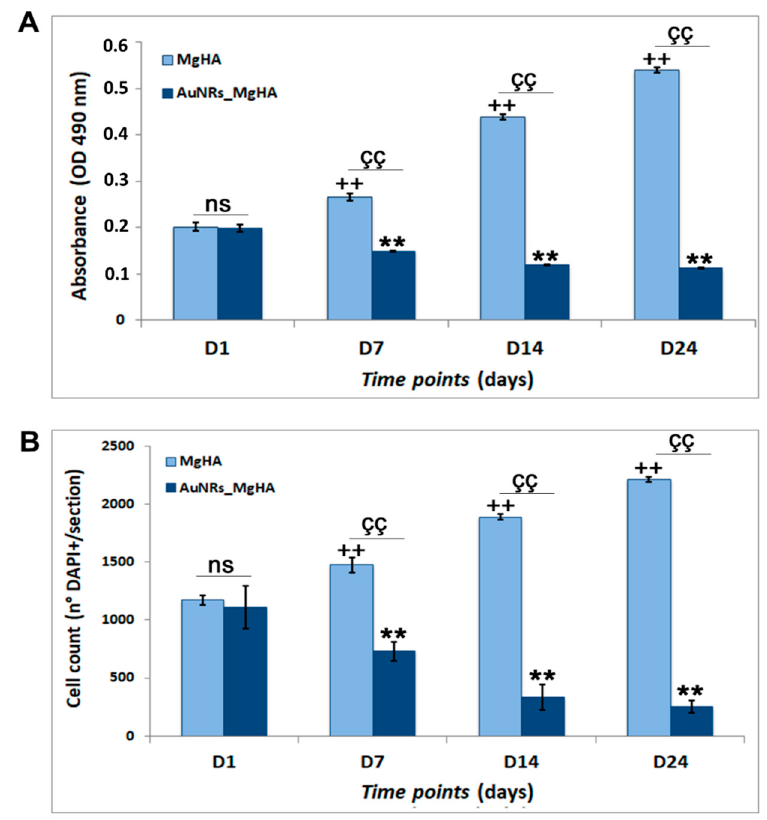
Figure 3. ( A ) Cell viability (MTS assay) after 1, 7, 14, and 24 days of hADSCs culture on MgHA and AuNR_MgHA scaffolds. ( B ) Cell count from DAPI staining at the four different timepoints of the culture. The ANOVA test p values reported (p < 0.0001) and (**, çç, ++ p < 0.01) and (p > 0.05 ns = not significant) indicate significant differences between scaffolds, as reported by the Tukey post-hoc test.